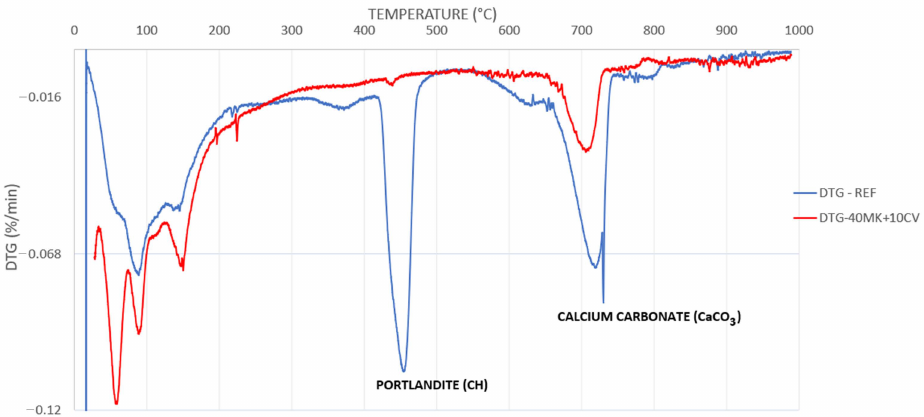
Figure 6. (DTG) curves of cement and blended paste (40 MK + 10 CV).